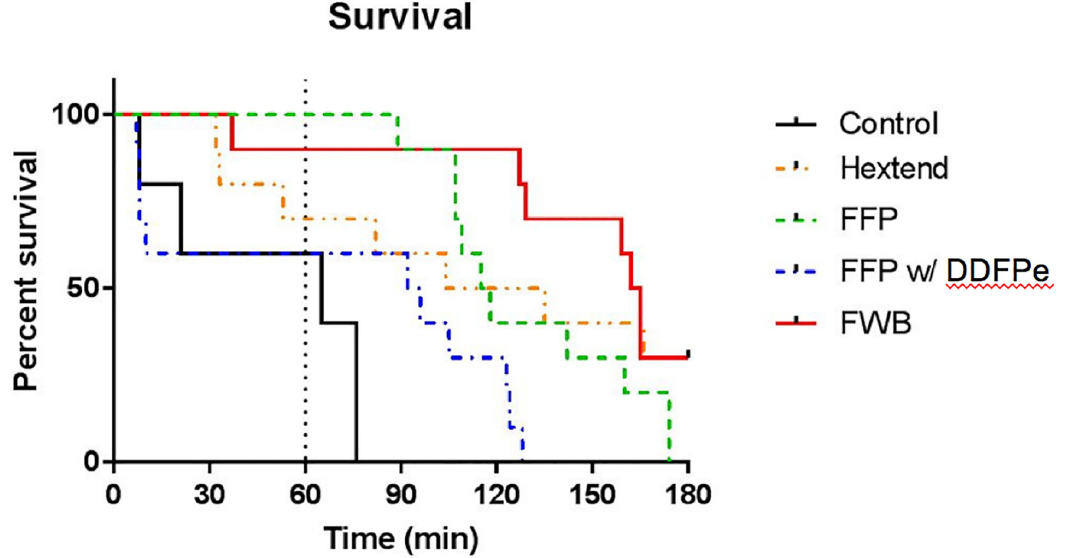
Fig 2. Survival analysis. Kaplan-Meier survival curve at 180 minutes post intervention. The vertical dotted line represents 60 minutes post intervention. Physiologic analysis was performed at this time point.